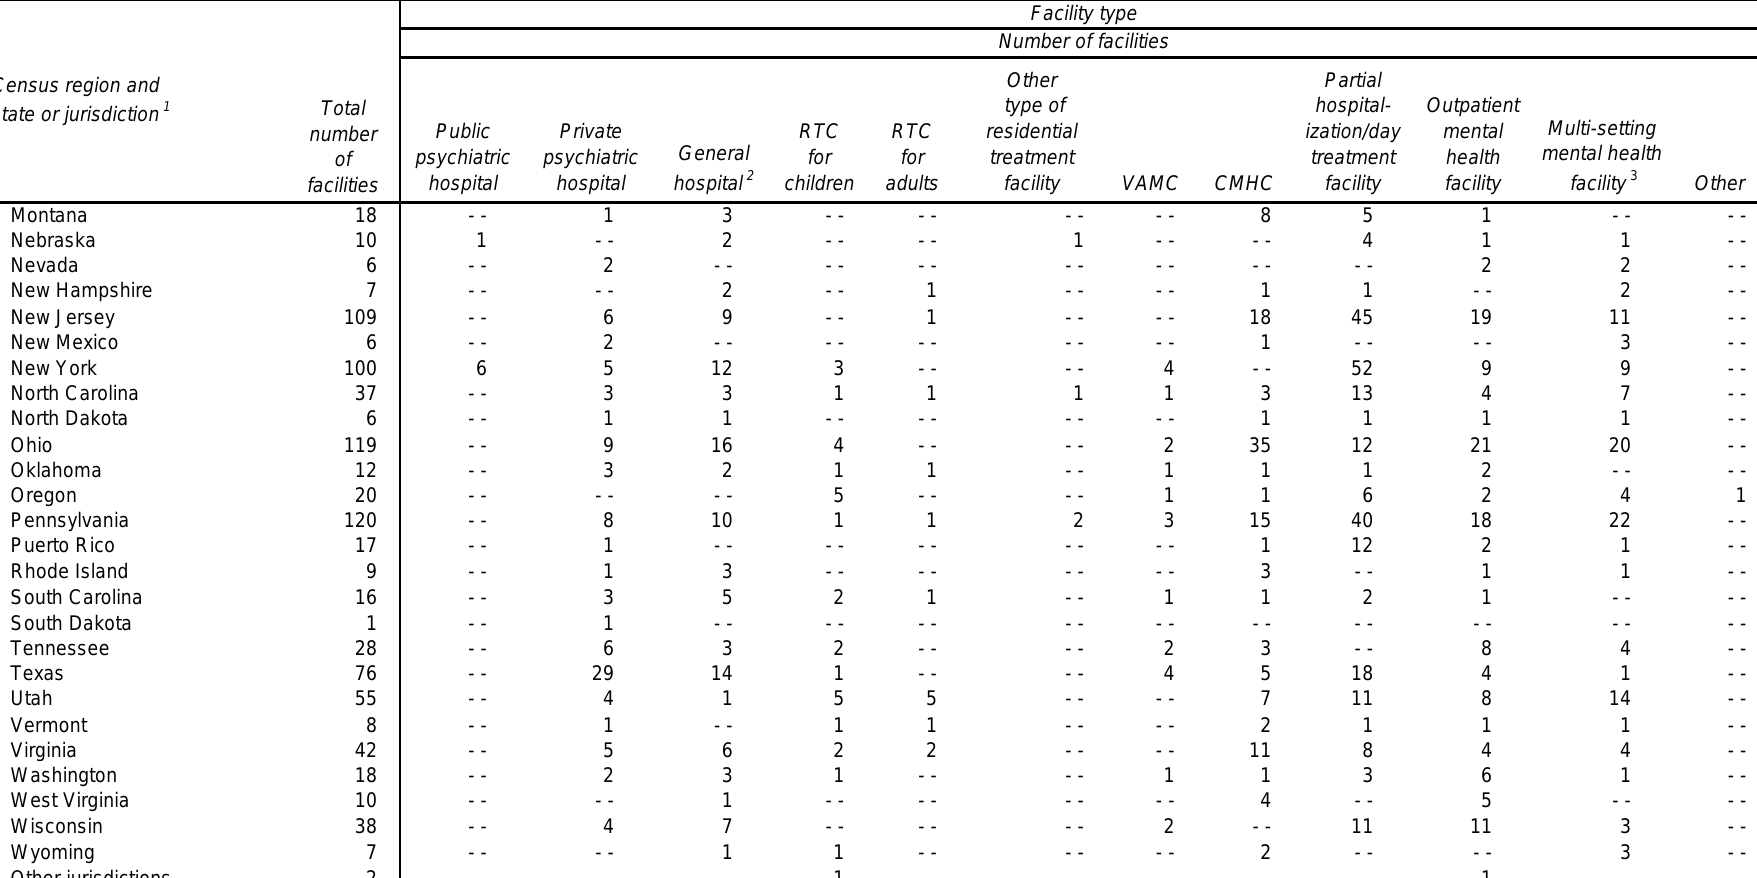
Table 3.5a. Mental health treatment facilities providing less than 24-hour partial hospitalization/day treatment, by facility type, Census region, and state